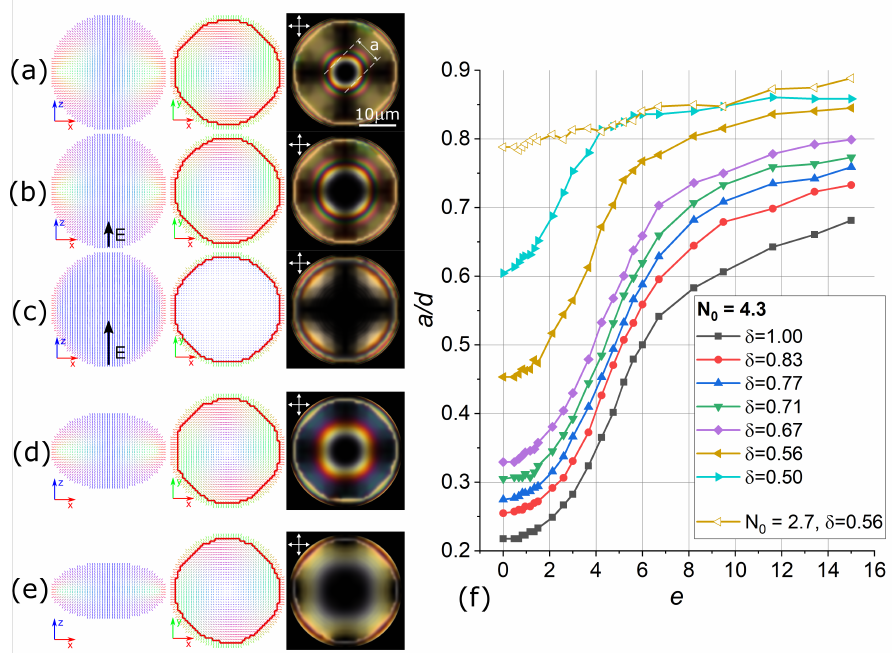
Figure 3. Calculated director distributions in the central cross-sections and simulated POM images for N 0 = 4.3 in spherical droplet at e = 0 ( a ), e = 4.2 ( b ), e = 15 ( c ), and in oblate droplets with δ = 0.67 ( d ), and δ = 0.5 ( e ) at e = 0. Calculated dependency a / d ( e ) for N 0 = 4.3 in droplets of various shapes ( f ). The scale remains the same in all